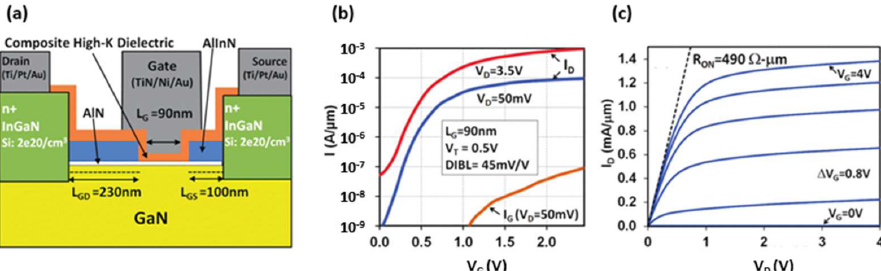
Figure 18. ( a ) Schematic of the e-mode high-K GaN MOS-HEMT. ( b ) I D -V G of the L G = 90 nm e-mode GaN MOS-HEMT showing low I OFF = 70 nA/µm (at V G = 0V, V D = 3.5V), and ( c ) I D -V D of the same device showing low on-resistance of R ON = 490 Ω µm [24] . Figure reproduced with permission from IEEE 2015 Symposium on VLSI Technology.